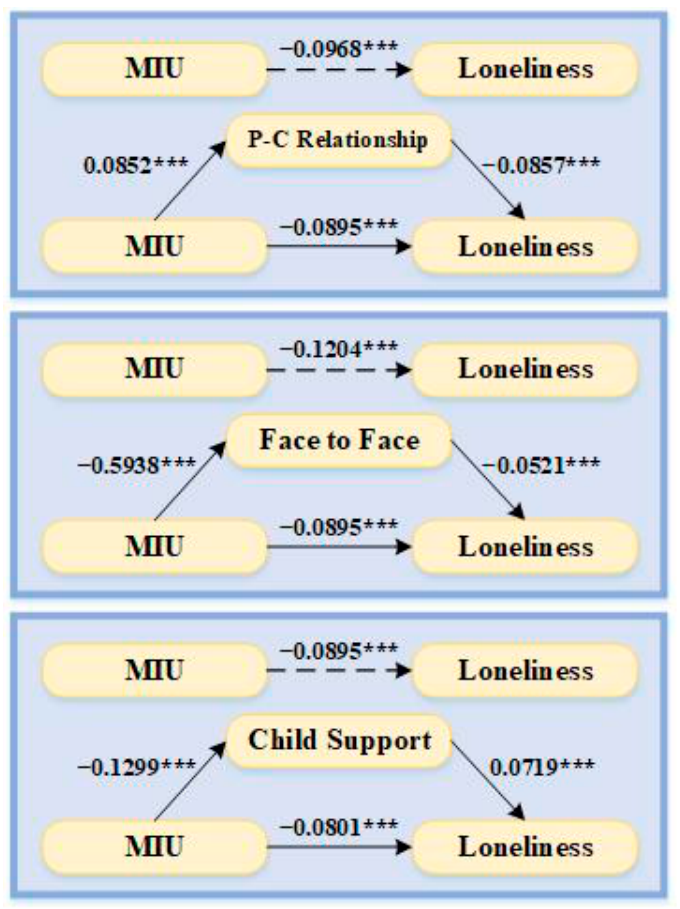
Figure 4. Mediation path map. Note: *** p <